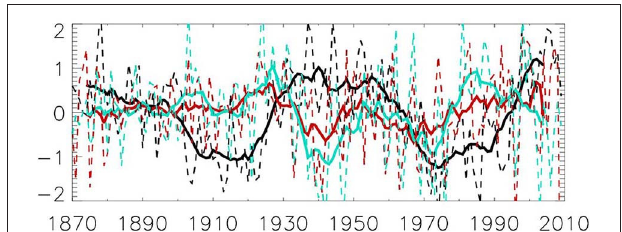
FIGURE 2 | Detrended and normalized (with the standard deviation) anomalies for the period 1870-2009 (140 years) of (1) annual mean North Atlantic (NA) SSTs (HadISST, Rayner et al., 2003) (black lines), (2) precipitation averaged over the Baltic Sea catchment area (9.6 to 32 ◦ E and 52.4 ◦ N to 67.4 ◦ N) from the HiResAFF dataset (Schenk and Zorita, 2012) (red lines) and (3) reconstructed river runoff integrated for the Baltic Sea catchment area (Meier et al., 2019b) (blue lines). Solid and dashed lines indicate low-pass filtered (10-year running mean) and annual mean values,